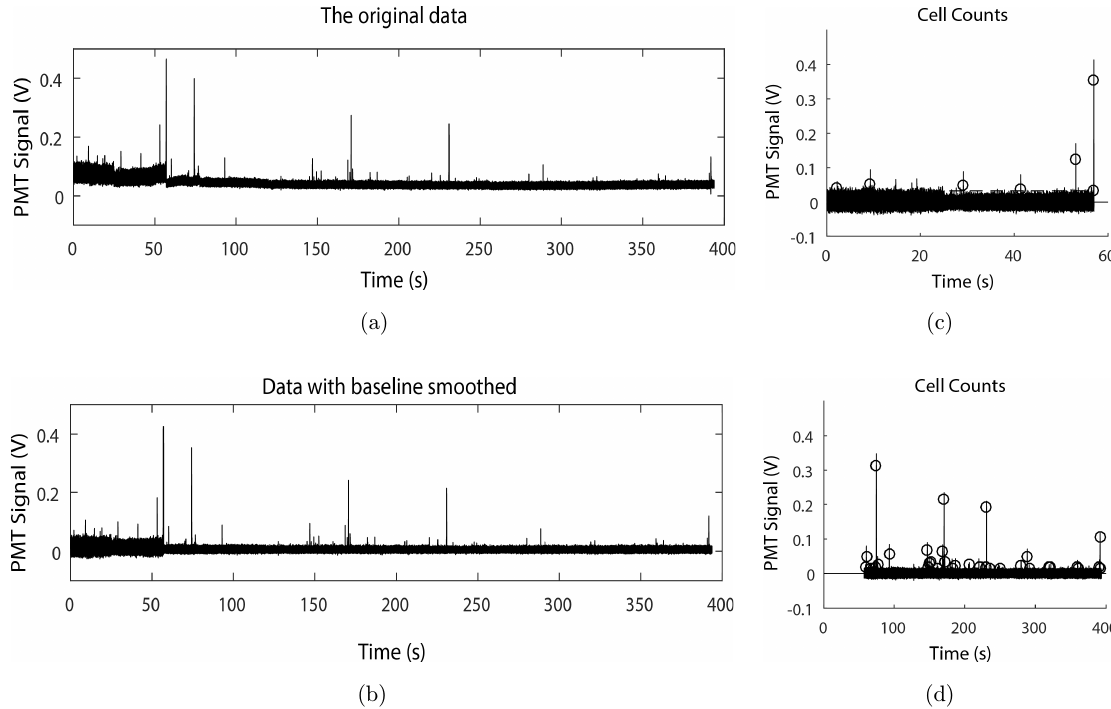
Fig. 4. A signal with baseline intensity change is divided into two parts and is processed separately. (a) The original signal has an obvious baseline intensity di®erence since the end of the ¯rst minute. (b) The baseline of signal is less °uctuated after baseline smoothing. (c) Cell peak counting result of the ¯rst signal part shows there are eight cells in the ¯rst minute. (d) The second part of the signal after auto-segmentation shows corresponding cell counting result (Table 1).